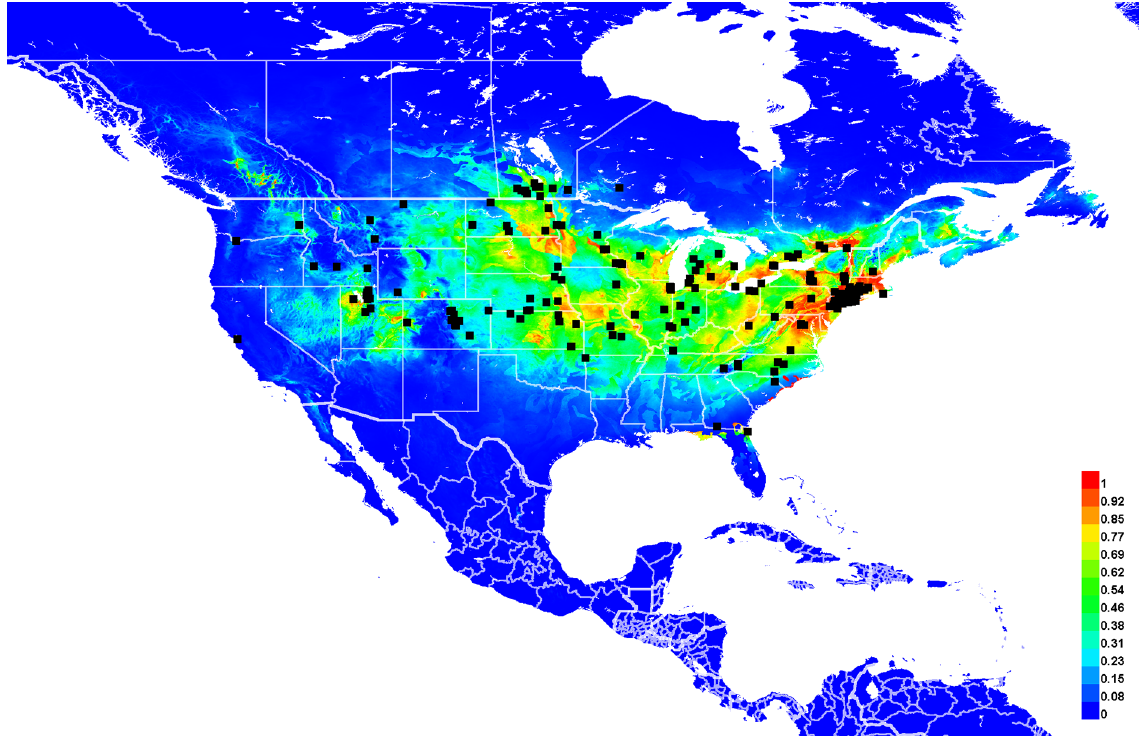
Fig. 89. Georeferenced collection records of Lasioglossum ( D. ) zephyrus (Smith, 1853) (black squares) and predicted distribution by maximum entropy ecological niche modeling in Maxent (colour shading). Warmer colours indicate higher cloglog probability of